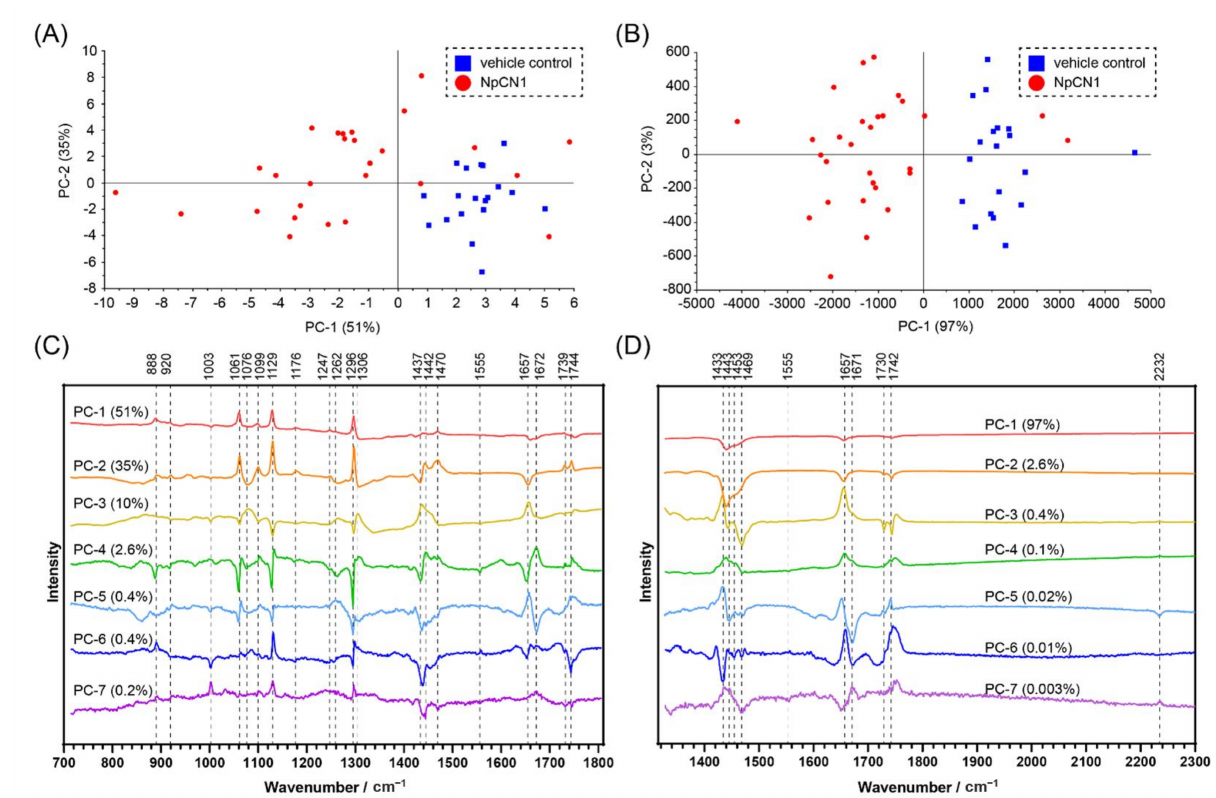
Figure 6. PCA of the average spectra of individual 3T3-L1 cells dosed with NpCN1 (20 µ M, 4 h) or equivalent volume DMSO as a vehicle control. Scores plots of the spectra from ( A ) 715 to 1806 cm − 1 and ( B ) 1327 to 2304 cm − 1 show a separation of the populations of cells. ( C , D ) show the loadings of the scores plotted in ( A , B ), respectively, along with the contribution of each